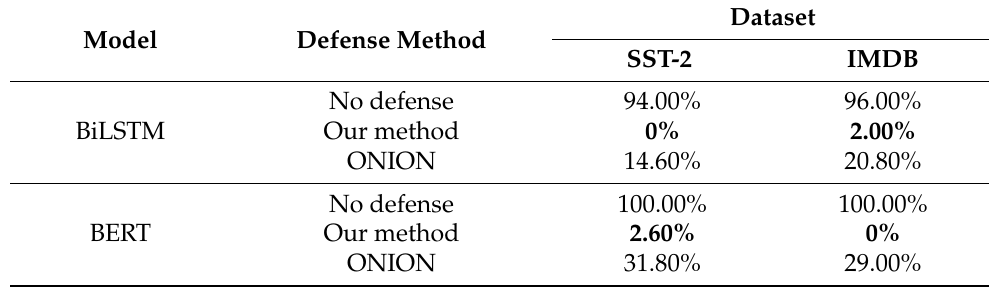
Table 4. Defense performance against word-level backdoor attack (%).